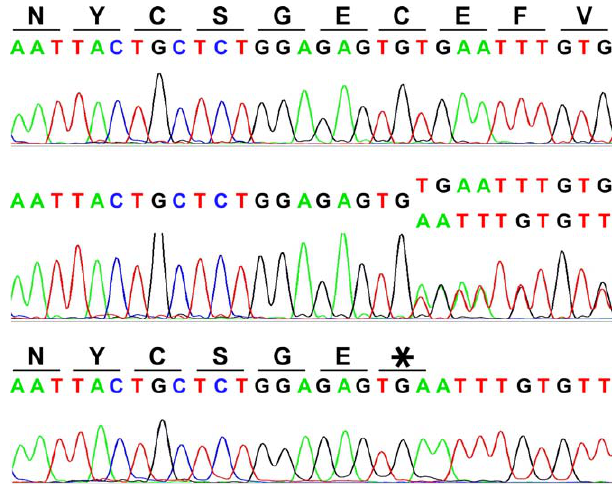
Figure 2. A 2-bp Deletion at Nucleotides 939 and 940 of the Canine MSTN Coding Sequence This deletion results in a cysteine ! stop codon change at amino acid 313. The top panel shows the sequence trace of a wild-type ( þ / þ ) individual in the region of the mutation. The middle panel shows the sequence trace of a mh/ þ individual with a single copy of both the wild- type and mutant alleles. The bottom panel shows the sequence trace from a homozygote ‘‘ bully ’’ dog of the mh/mh genotype. The amino acid sequences for þ / þ and mh/mh individuals are located above each trace.